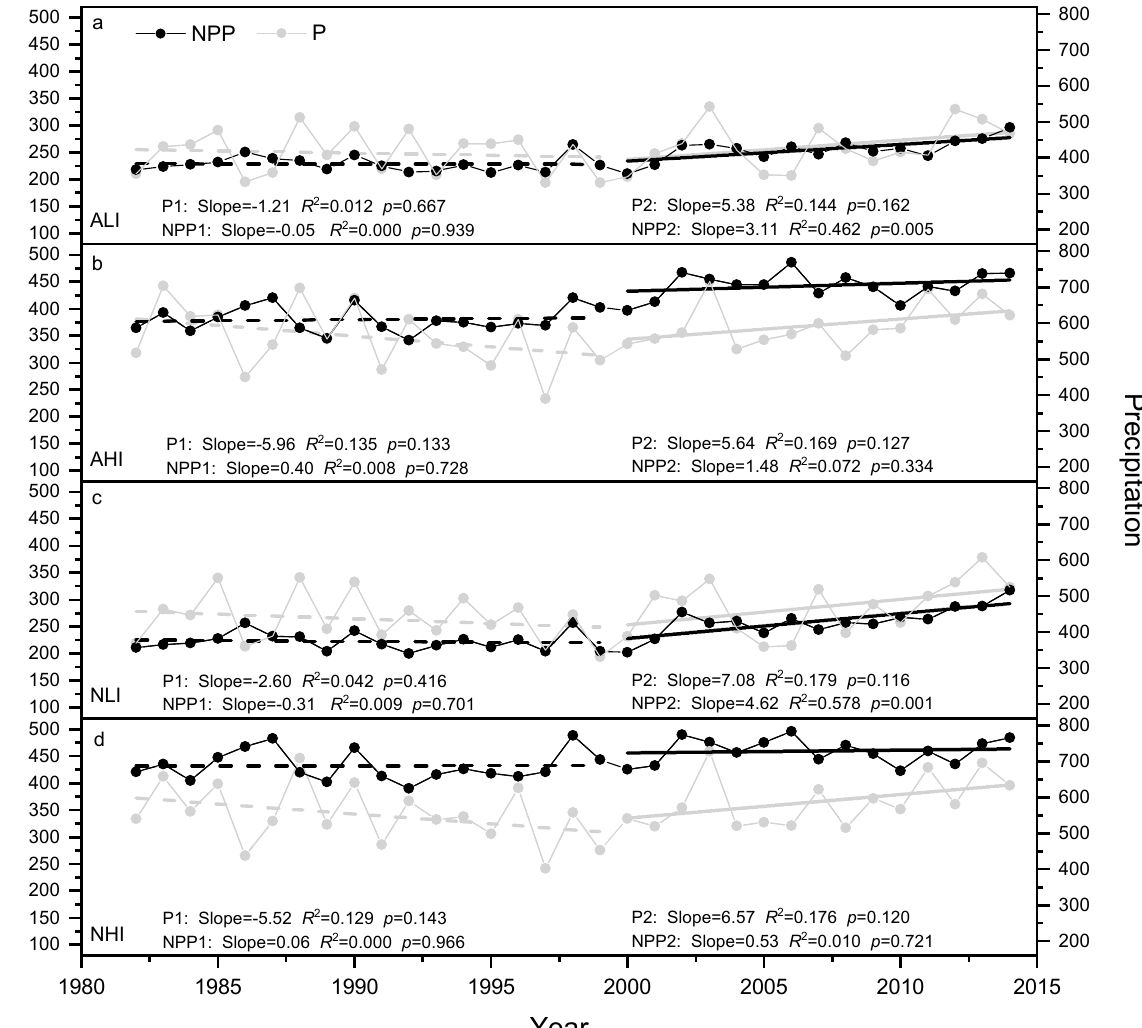
Figure 3. Trends of NPP (black circle) and precipitation (P) (grey circle) in artificial and natural tree cover increase areas in 1982–1999 (NPP1 and P1) and in 2000–2014 (NPP2 and P2), respectively. ( a ) ALI: Artificial forest with a limited increase, ( b ) AHI: Artificial forest with a high increase, ( c ) NLI: Natural forest with a limited increase, ( d ) NHI: Natural forest with a high increase. A comparison of NPP, ET and WUE was made between artificial and natural forests under similar precipitation and geographically close conditions (within West Zone, WZ, and East Zone, EZ). In the EZ, NPP had a significant increase of 7.6 gC·m 2 y − 1 in 2001–2014 ( p < 0.01), and no difference was found between artificial and natural forested areas. ET significantly increased at a rate of 5.2 mm y − 1 and was constantly higher for the natural forest in the EZ ( p < 0.01). The divergence in ET resulted in larger WUE in the artificial forest than natural forest in the EZ (Figure 4e). In contrast, both NPP and ET had no